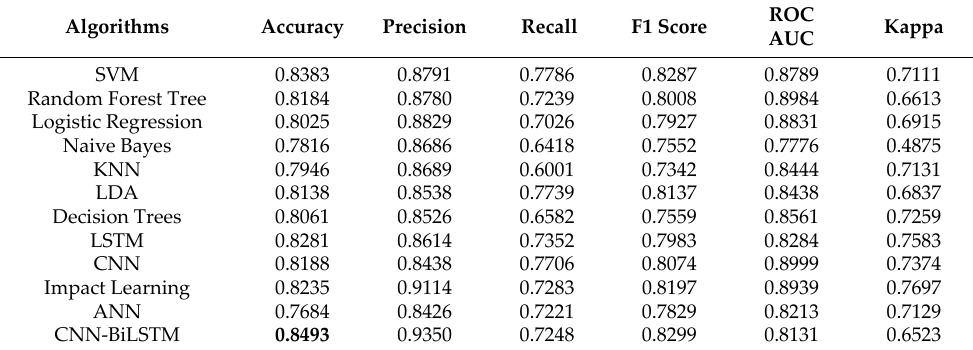
Table 3. Performance of Word2Vec.